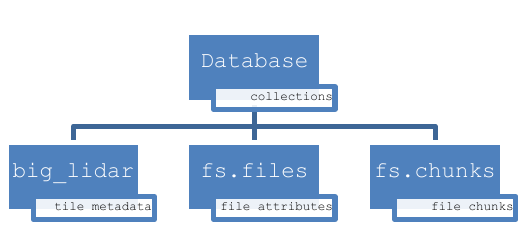
Figure 2: Overview of the three collections that make up the database for big LiDAR data